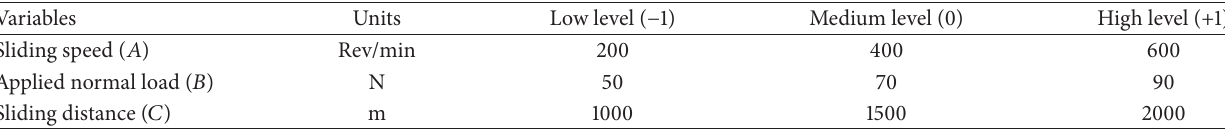
Table 2: Design layout of independent variables and their levels.